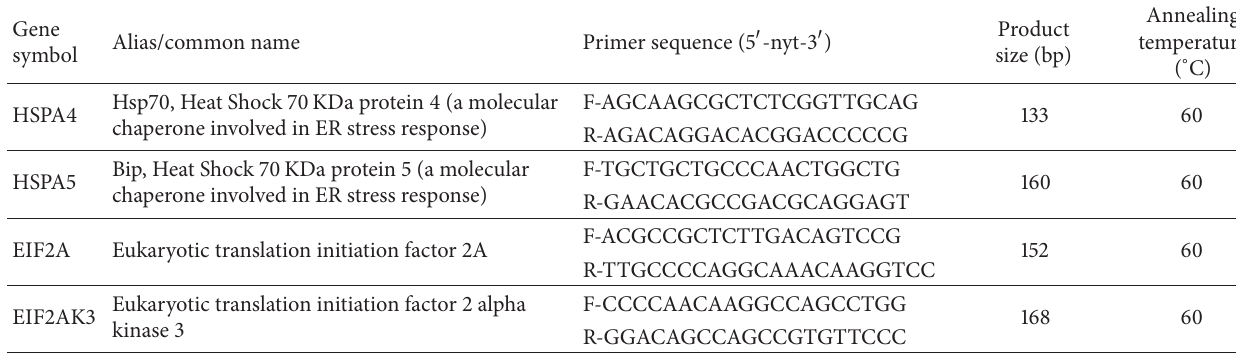
Table 1: Primer sets used in real-time quantitative PCR